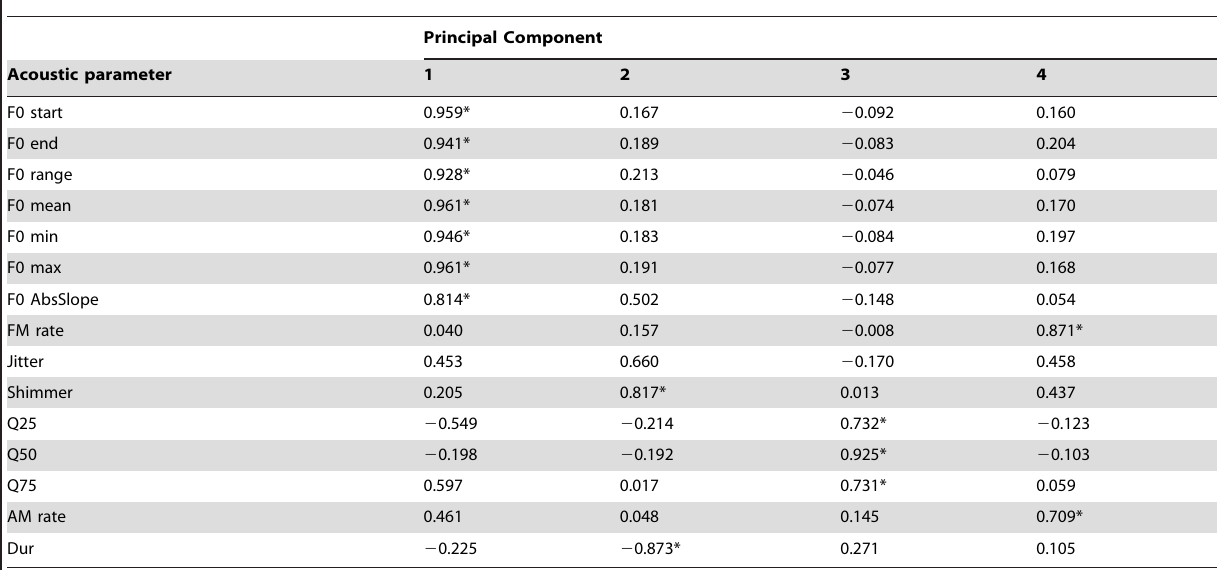
Table 3. Results of the principal component analysis with varimax